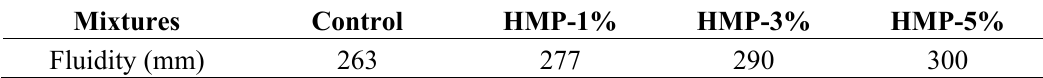
Table 5. Fluidity of control and HMP